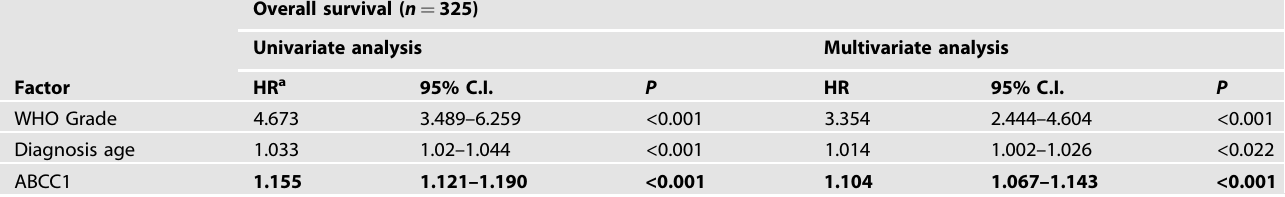
Table 1. Univariate and multivariate analysis for OS of glioma patients from the CGGA cohort according to ABCC1 expression. Overall survival ( n = 325)